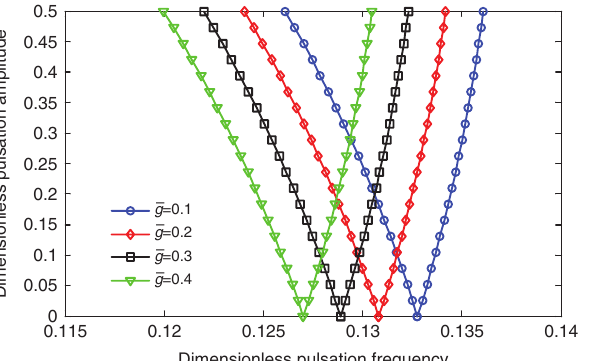
Figure 9: Effect of the spring constants of viscoelastic foundation on the dimensionless pulsation amplitude versus dimensionless pulsation